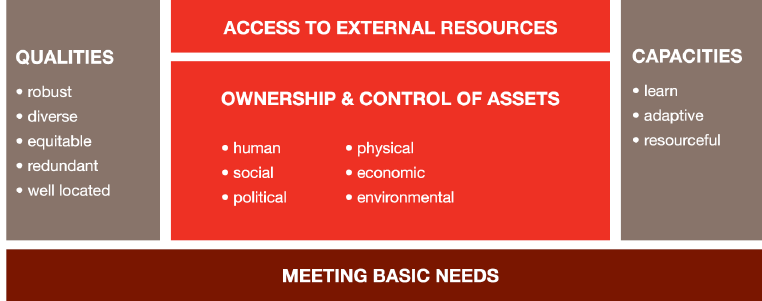
Figure 1. Conceptual framework of community resilience (source: IFRC,